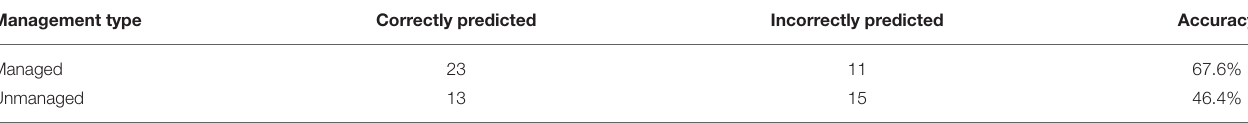
TABLE 3 | Classification flow diagram validation.